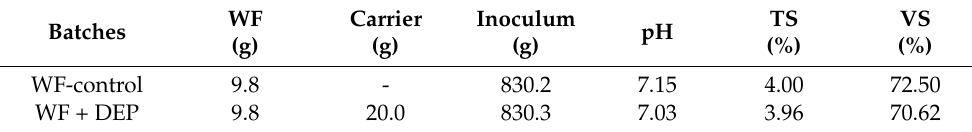
Table 1. Composition and selected properties of the feedstock/inoculum